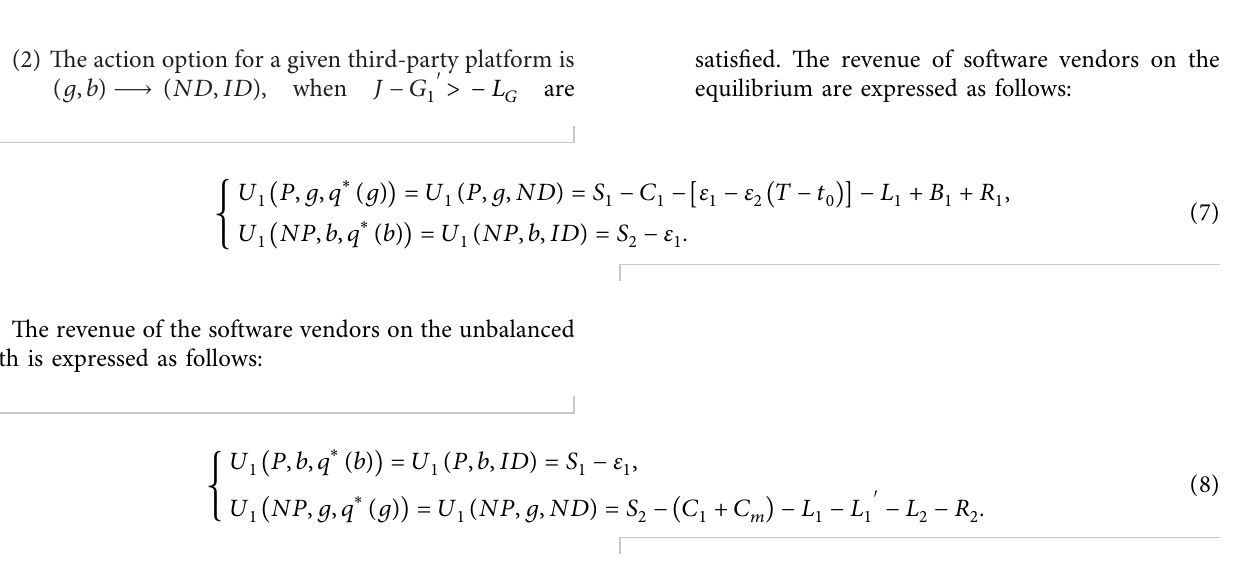
Figure 2: A dynamic game model of signal transmission in fxed protection